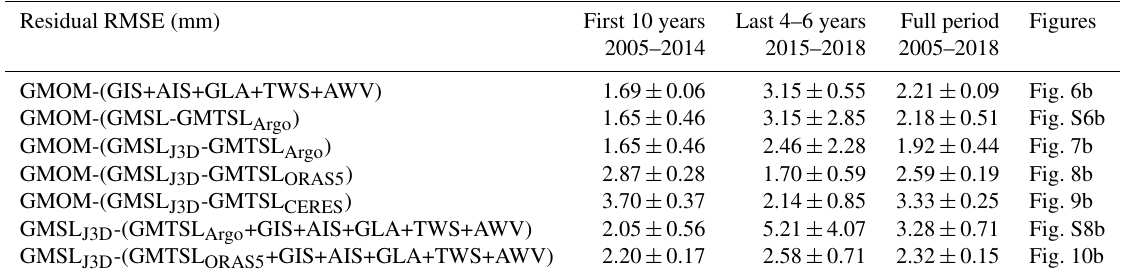
Table 1. Budget residual root mean square errors (RMSEs) in mm. GMSL J3D stands for the altimetry-based GMSL corrected for the Jason- 3 WTC drift. GMTSL Argo , GMTSL ORAS5 and GMTSL CERES stand for the GMTSL estimated from the Argo ensemble mean, from the ORAS5 ocean reanalysis and from CERES observations respectively. RMSE values are computed over common periods of time to enable comparisons (from 1 January to 31 December of the specified years).